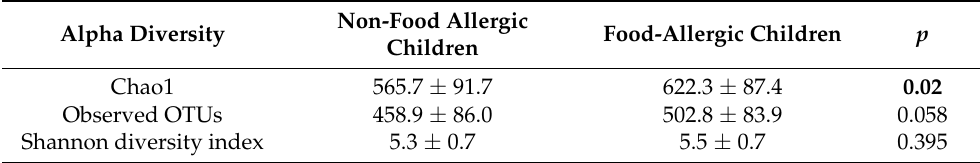
Table 1. Comparison of gut microbial alpha diversity between food-allergic children and non-food allergic children. Values represent mean ±